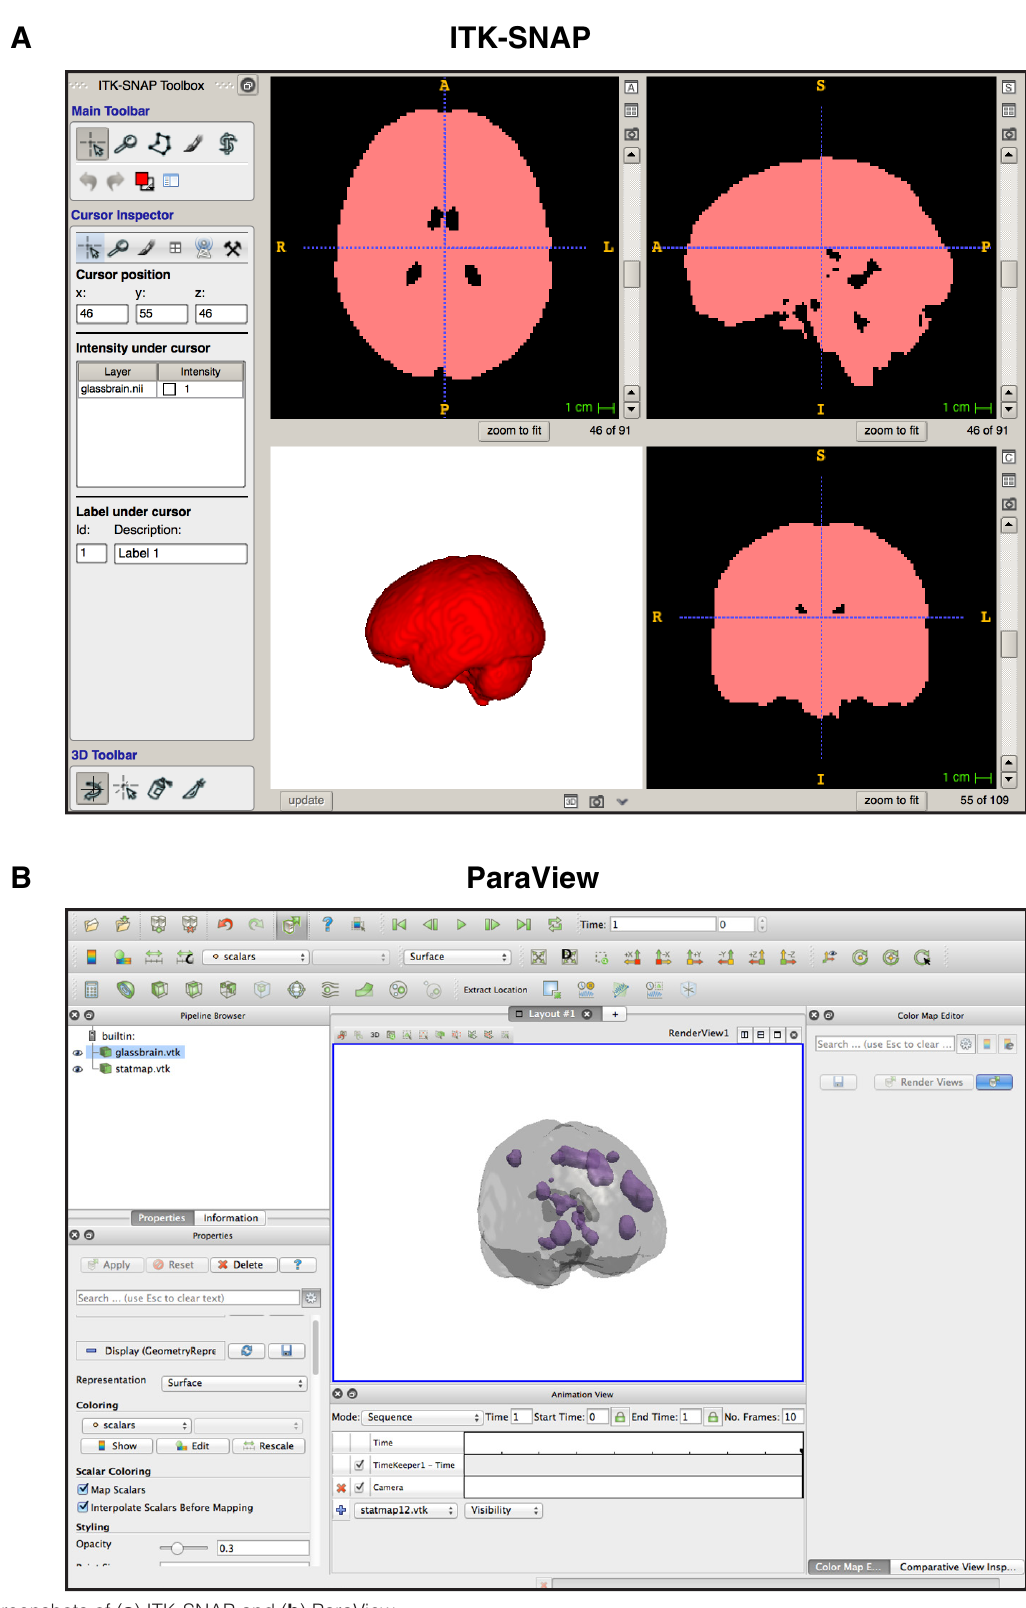
Figure 2. Screenshots of ( a ) ITK-SNAP and ( b )